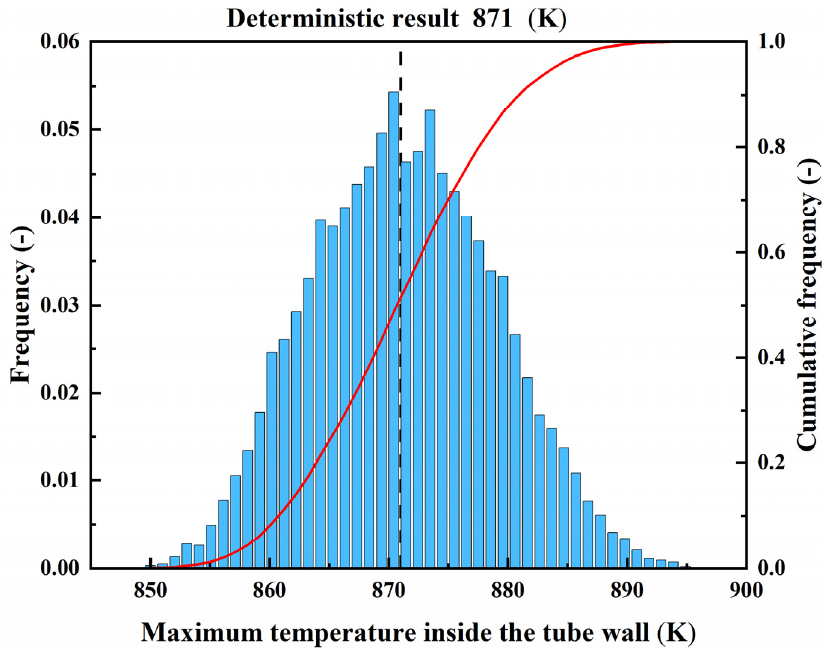
Figure 10. Probability distribution of the maximum temperature inside the tube wall under uncer- tainty.